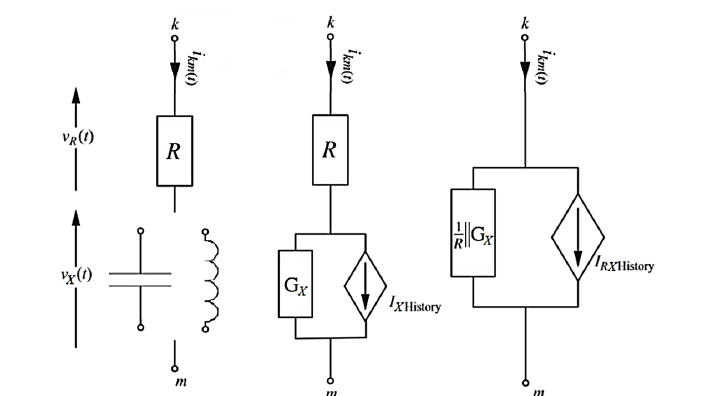
Figure 6. Series Resistor–Inductor (RI)/Resistor–Capacitor (RC) Branch Reduction.